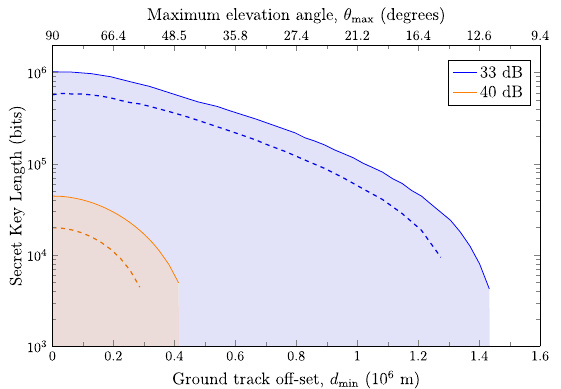
Fig. 7 Protocol effect on SKL vs ground track offset. Shown are a-BB84 (solid lines) and s-BB84 (dashed lines) with p ec = 5 × 10 − 7 , QBER I =